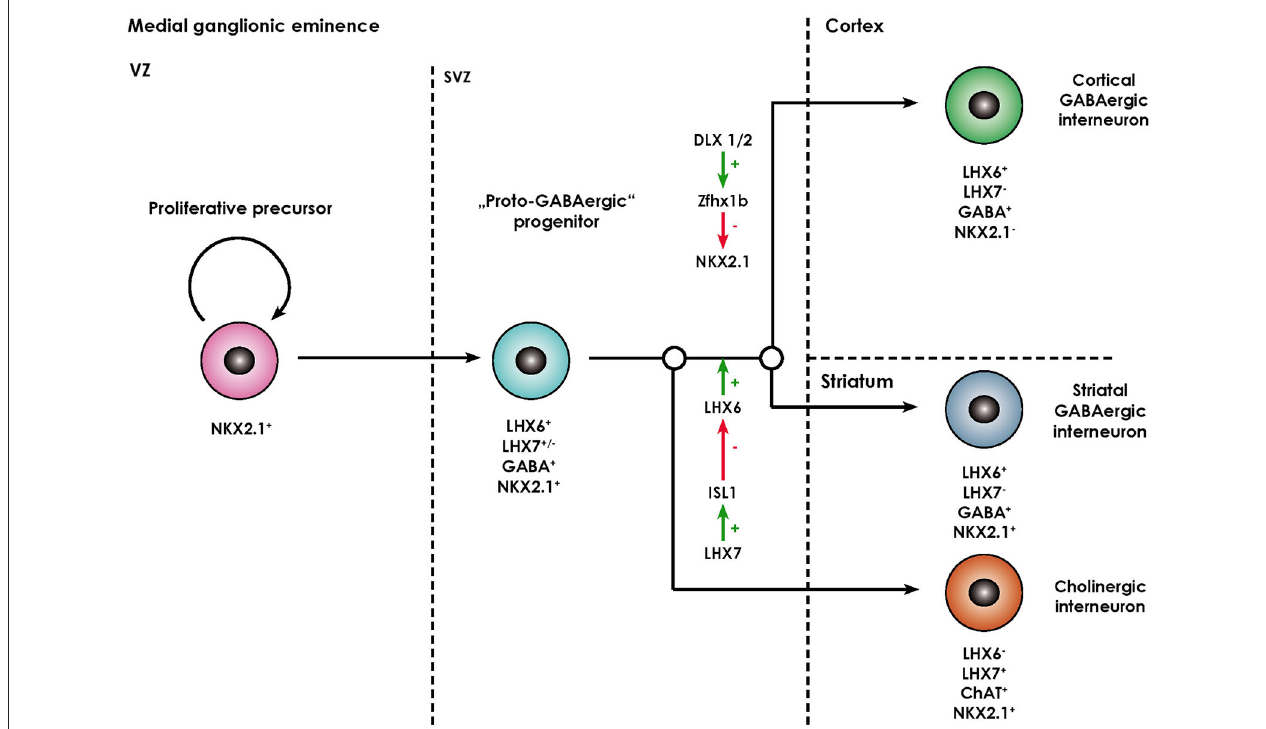
maintained, they either continue to express NKX2.1 and differentiate towards striatal GABAergic interneurons. Alternatively, the zinc finger homeobox gene Zfhx1b, which acts downstream of DLX1/2, represses NKX2.1 expression, in which case cortical GABAergic interneurons arise. Through ISL1, LHX7 expression leads to a repression of LHX6 and thus differentiation towards cholinergic neurons positive for choline acetyl transferase